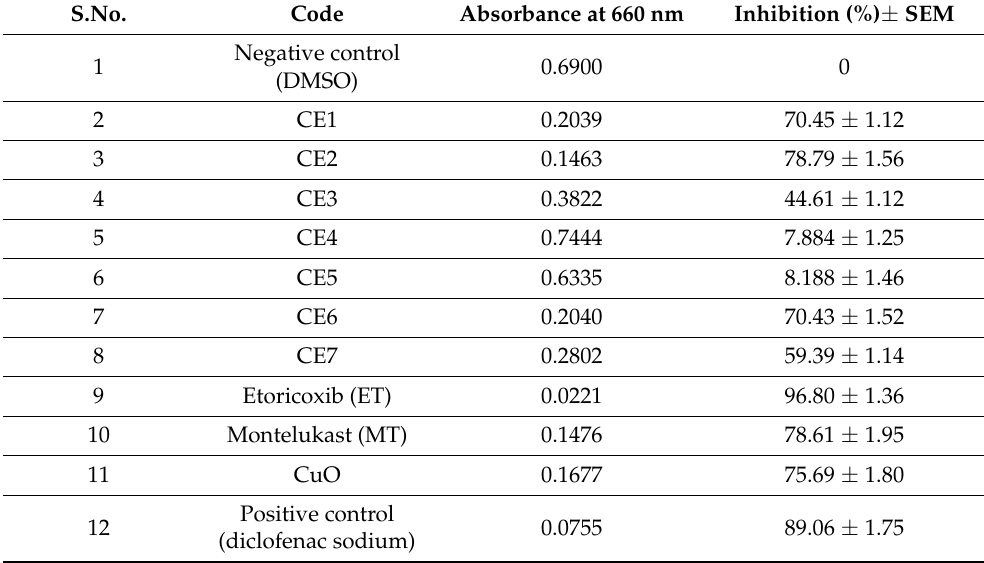
Table 3. In vitro anti-inflammatory